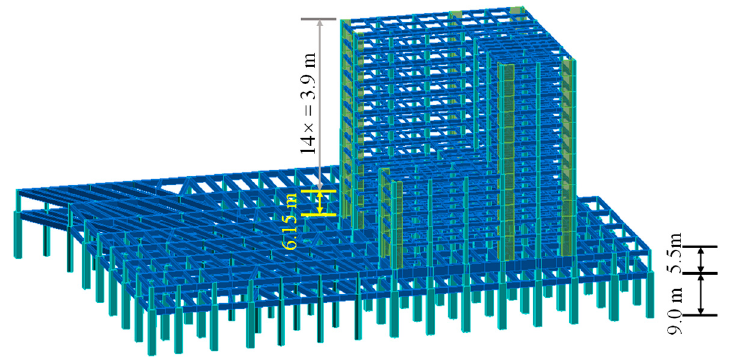
Figure 2. Layout of the 14-storey Building G1.